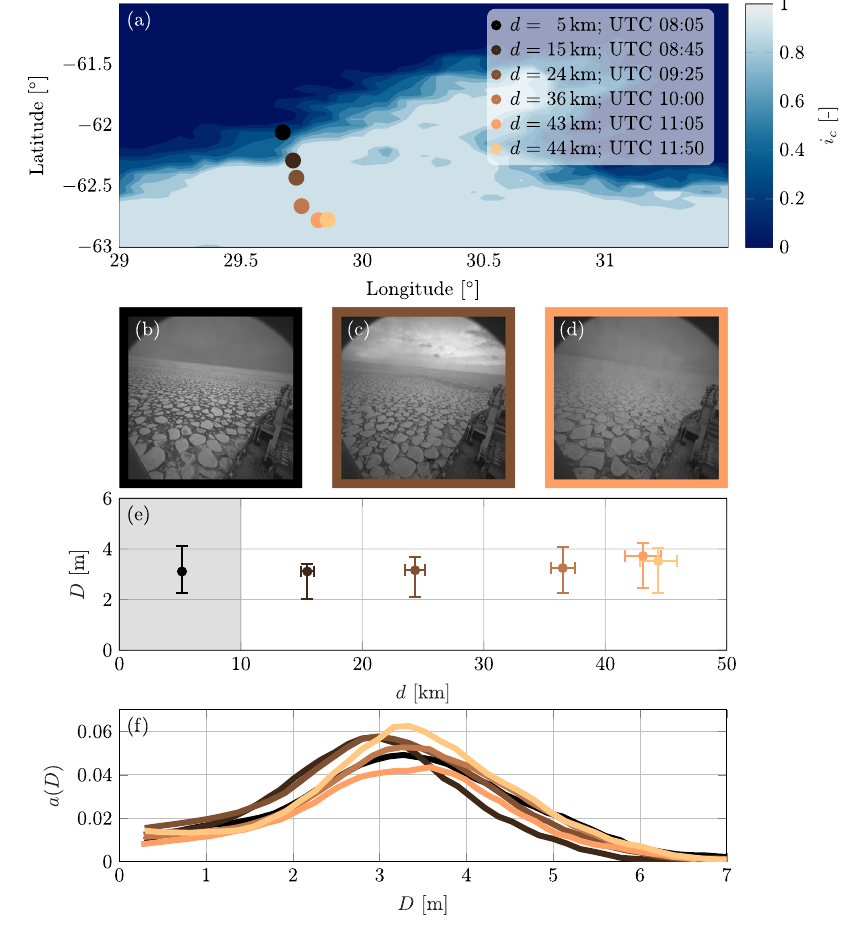
Fig.2|Sea-icepropertiesonthe4thJuly2017.a Overviewofstudyareawithsea- ice concentration from AMSR2 on the 4th July 2017 (longitude and latitude are horizontal and vertical axes, respectively), with bullets indicating six mean mea- surement locations during 20min acquisitions. b – d Example of image acquisitions (axes in pixels) at d =5km, 24km and 43km from the ice edge, respectively. e Median pancake fl oe diameter ( D , verticalaxis)versus distancefrom the edge ( d ,